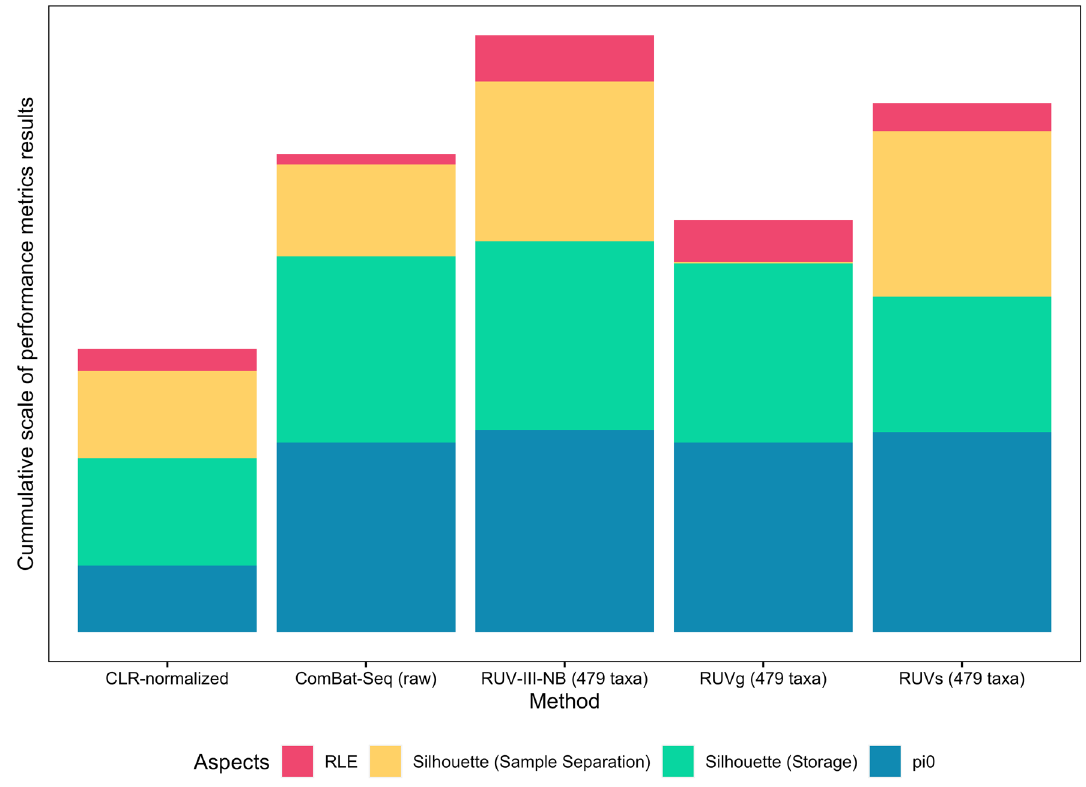
Figure 4. Summarized plot showing the performances of all the methods used to remove unwanted variations in pig faecal samples. For methods utilizing control features (RUVg, RUVs, and RUV-III-NB), we only picked the attempts using combination control taxa (479 taxa) as they demonstrated overall best performances within each method. For every method represented by the stacked bar, each color represents the performance of each method in each specific metric (as previously shown in Fig. 3); for visual uniformity, a taller stacked bar represents overall better performance. For RLE, the value represented was taken from 1-overall canonical correlation of the RLE metrics and known unwanted technical variations; for silhouette (storage), the value was taken from 1- average width of silhouette statistics score for clustering by storage